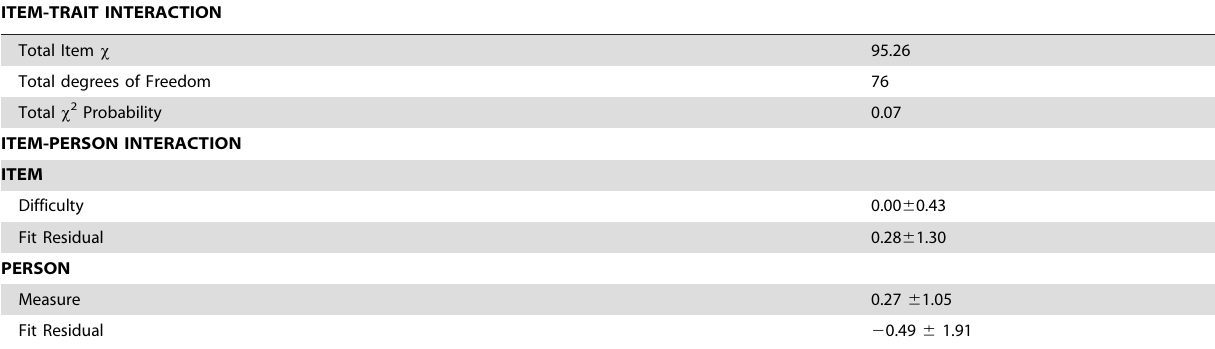
Table 3. Indices of fit to a Rasch